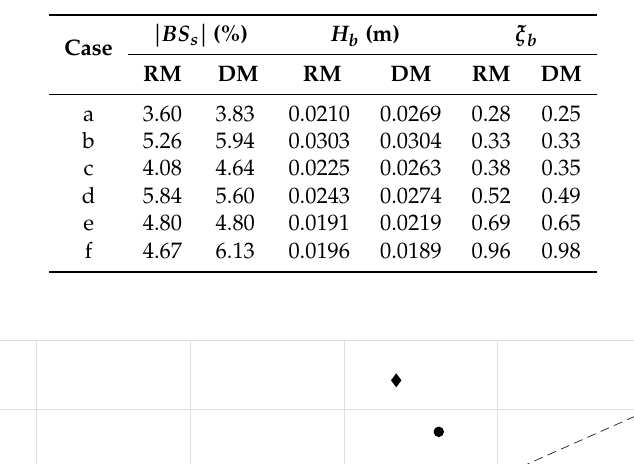
Table 4. Wave breaking conditions for the tested cases.